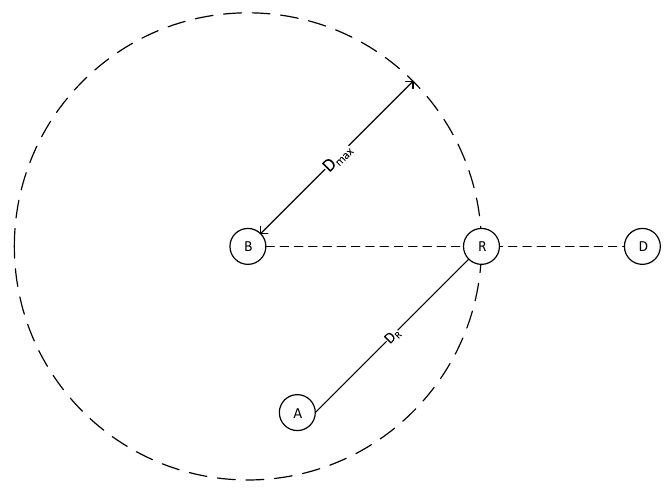
Figure 2. Rebroadcast Forwarding Priority.